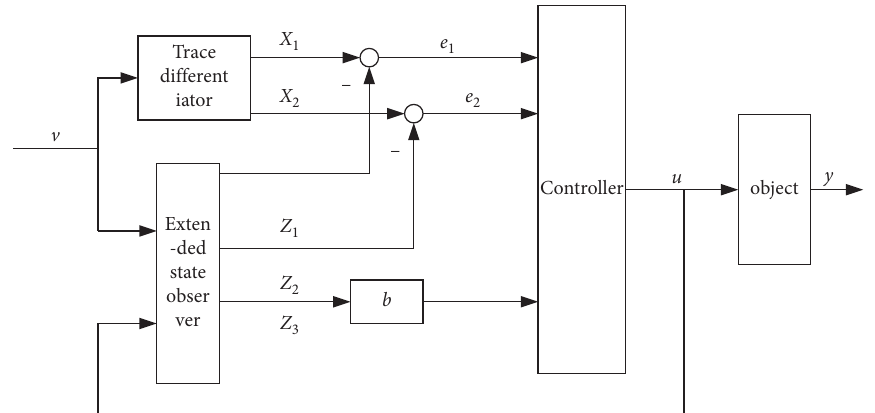
Figure 2: The structure of the improved automatic disturbance rejection control system.